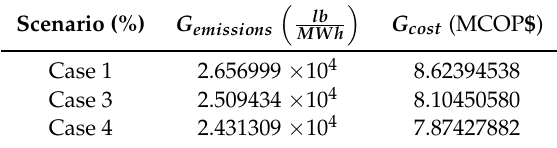
Table 7. Evaluation of C 1 , C 3 , and C 4 for the 69-node test